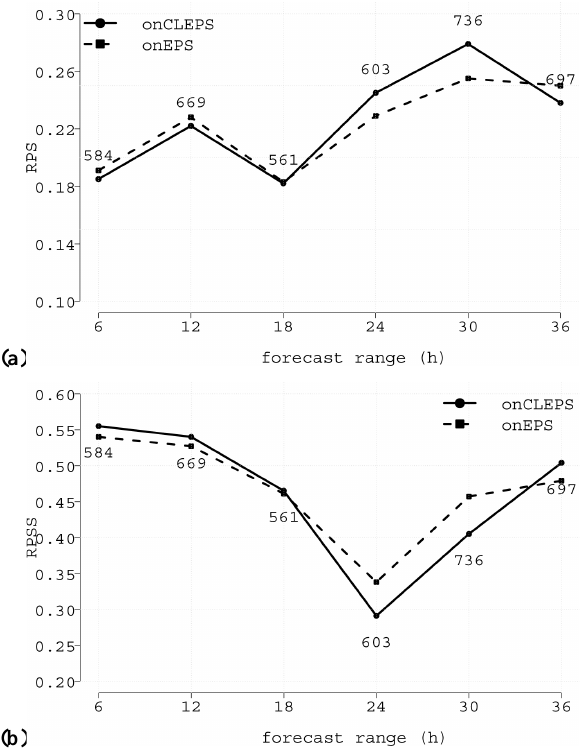
Fig. 8. Ranked probability score (a) and skill score (b) of COSMO-H2-EPS (solid line, labelled “onCLEPS”) and EXP-H2- EPS (dashed line, labelled “onEPS”) as a function of the fore- cast range. Verification is performed for 6-hourly precipitation over northern and central